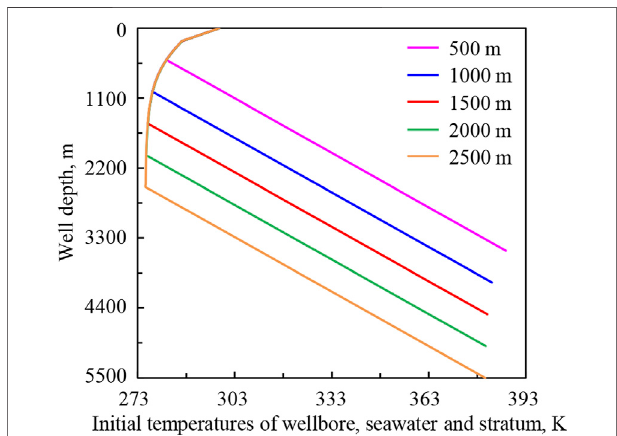
FIGURE14| Variationregularities ofwellboretemperature fi eld,pressure fi eld,andhydrateformationregionindeep-waterdrillingunderdifferentseawaterdepths: (A) annulus temperature, (B) temperature difference between the drilling fl uid in the annulus and in the drill string, (C) annulus pressure and phase equilibrium pressure, (D) hydrate formation region. The solid lines under different seawater depths in (C) are overlapped in the upper well section.